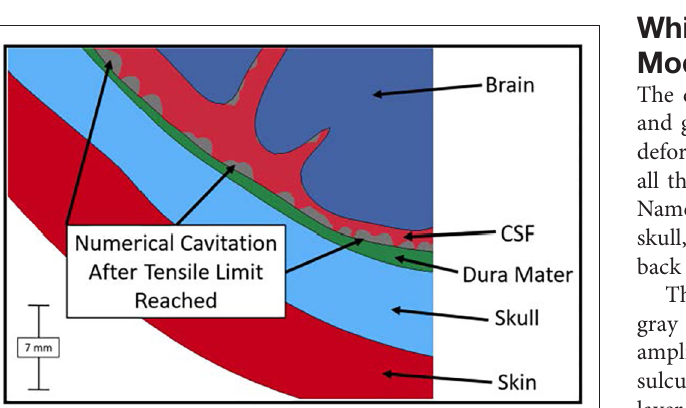
simulation results with gyrification. However, the shear strain amplification at the base of sulci is not captured in the smooth brain